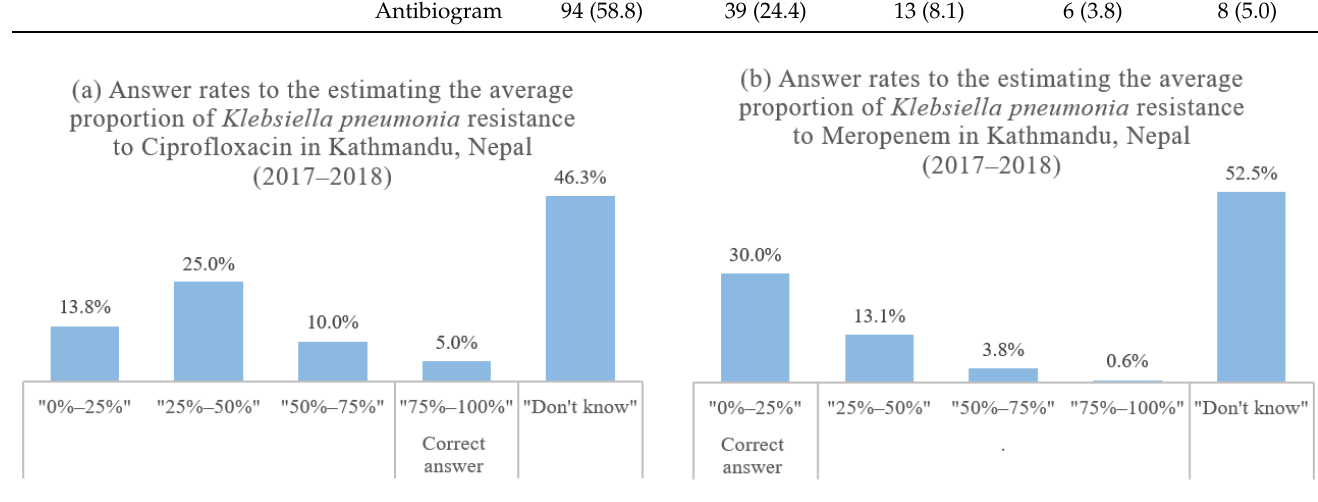
Figure 1. Answer rates to the questions of current AMR rates in the community: Klebsiella pneumonia to ( a ) ciprofloxacin and ( b ) meropenem in Kathmandu, Nepal ( n = 160).